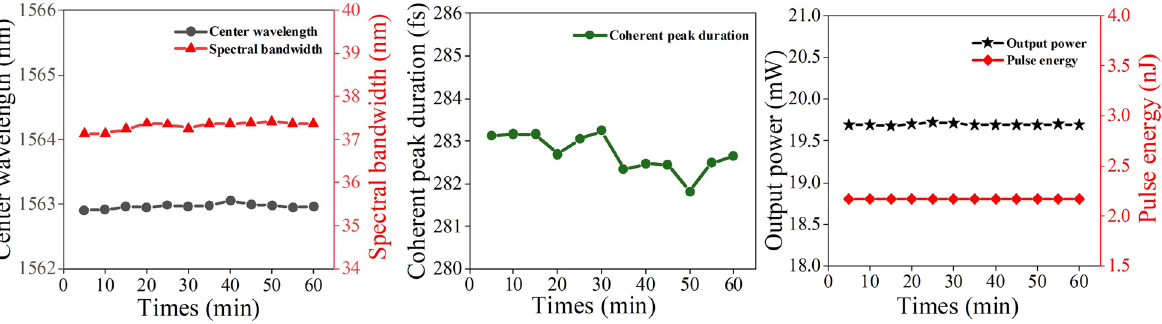
Figure 11: Stability of passively mode-locked NLP output of GDY saturable absorber, (a) center wavelength and spectral bandwidth against times, (b) coherent peak duration against times, (c) output power and pulse energy against